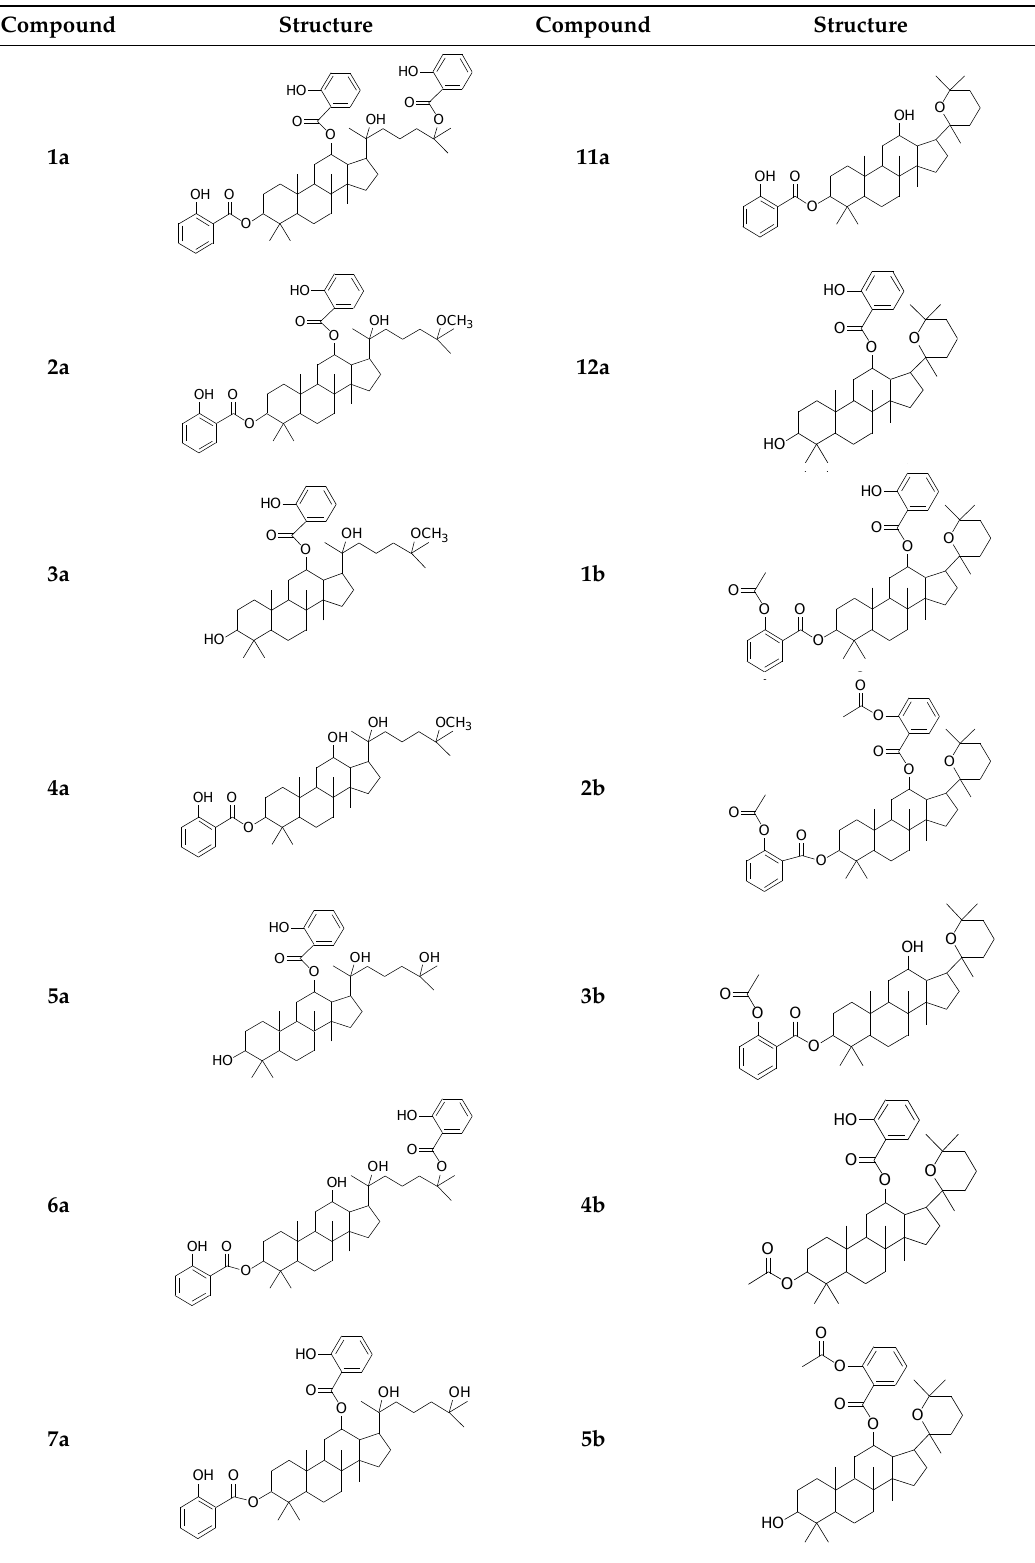
Table 1. Products of ginsenosides with salicylic acid and acetylsalicylic acid. Compound Structure